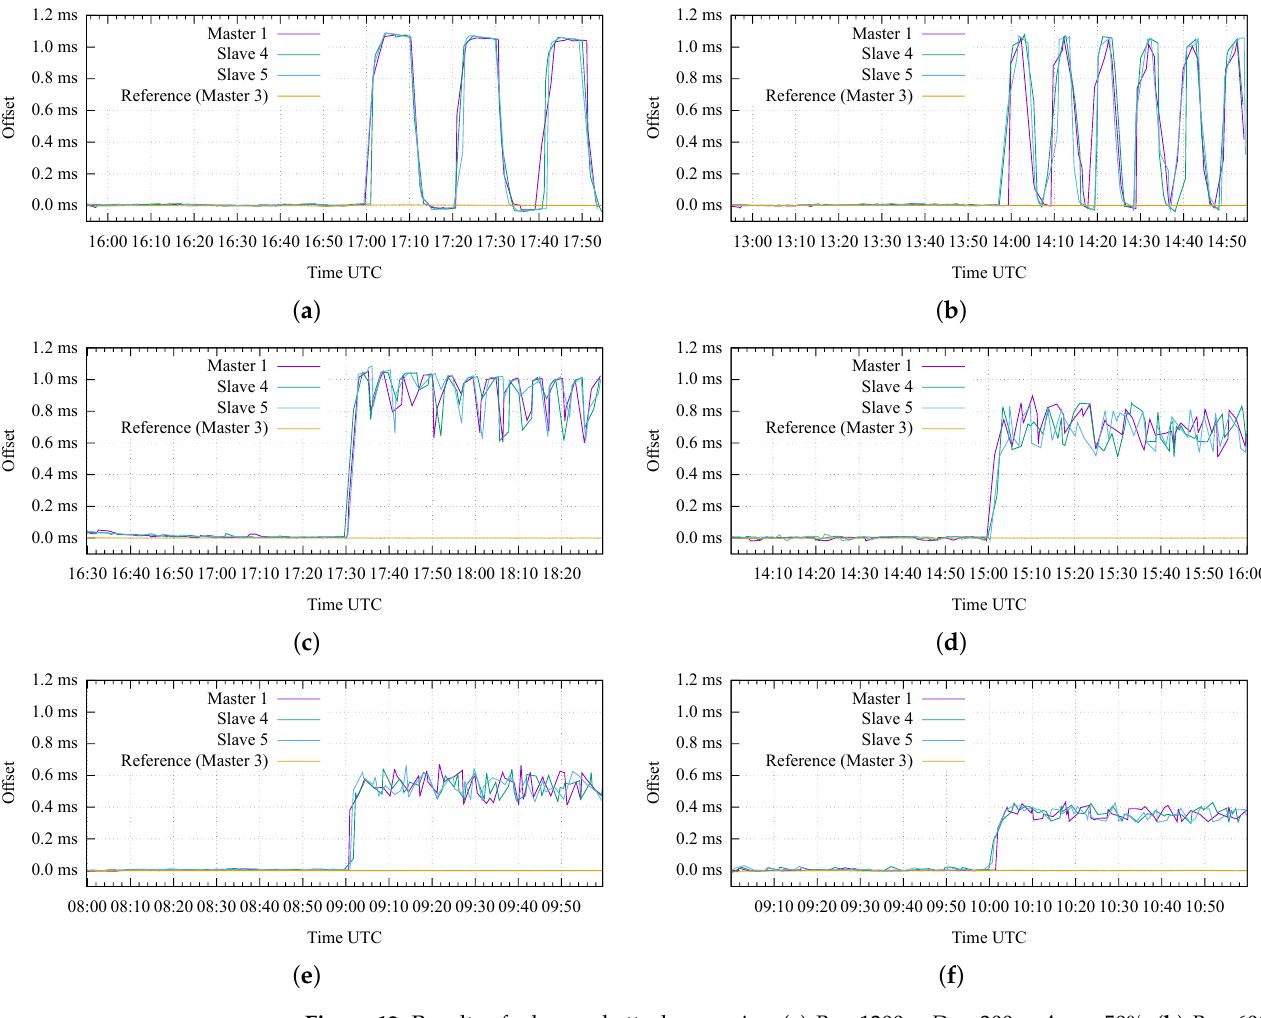
Figure 12. Results of advanced attack scenarios: ( a ) P = 1200 s, D = 300 s, A D = 50%; ( b ) P = 600 s, D = 150 s, A D = 50%; ( c ) P = 300 s, D = 15 s, A D = 90%; ( d ) P = 90 s, D = 15 s, A D = 66.7%; ( e ) P = 60 s, D = 15 s, A D = 50%; ( f ) P = 45 s, D = 15 s, A D = 33.3%. Figure 12a corresponds to the case where the RA protocol is repeated every 20 min and the attack duty cycle is A D = 50%. In this case, the attacker repetitively introduces